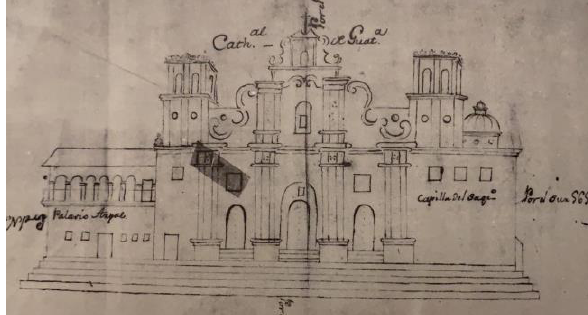
Figure. 2. Archival image of the 17th century facade of the Cathedral of Santiago de los Caballeros, which was the basis for architectural modeling. Image provided by the Historical Team.